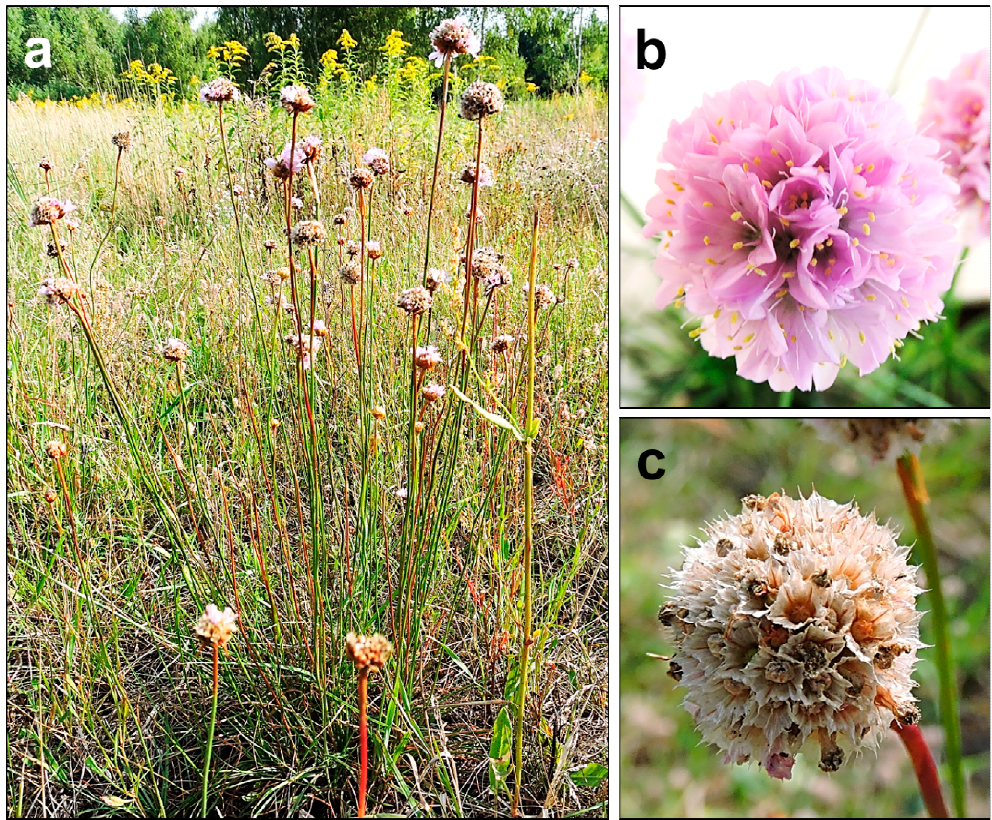
Figure 1. The appearance of A. maritima plants from the area near Warsaw (Poland), not contaminated with heavy metals: ( a ) habitat of the whole plant; ( b ) inflorescence with developed flowers; ( c ) seeds in calyxes. All photos by Olga Bemowska-Ka ł abun. Table 1. Comparison of the appearance, morphology, and occurrence of three selected subspecies of A. maritima (based on: Szafer, 1946 [71]; Pinto da Silva, 1972 [69]; Lefèbvre, 1974 [76]; Woodell and Dale, 1993 [74]; Abratowska et al., 2012, 2015 [23,47]; W ą sowicz, 2015 [72]). Subspecies of A. maritima Features/Occurrence Subsp. Elongata Subsp. Maritima Subsp. Halleri